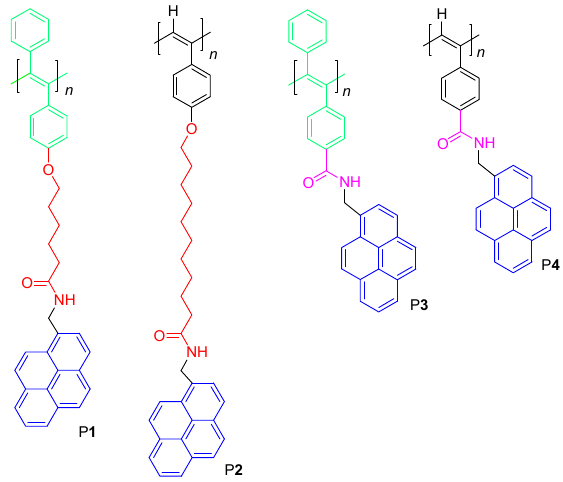
Figure 1. The chemical structures of the pyrene-functionalized polyacetylenes in this work.